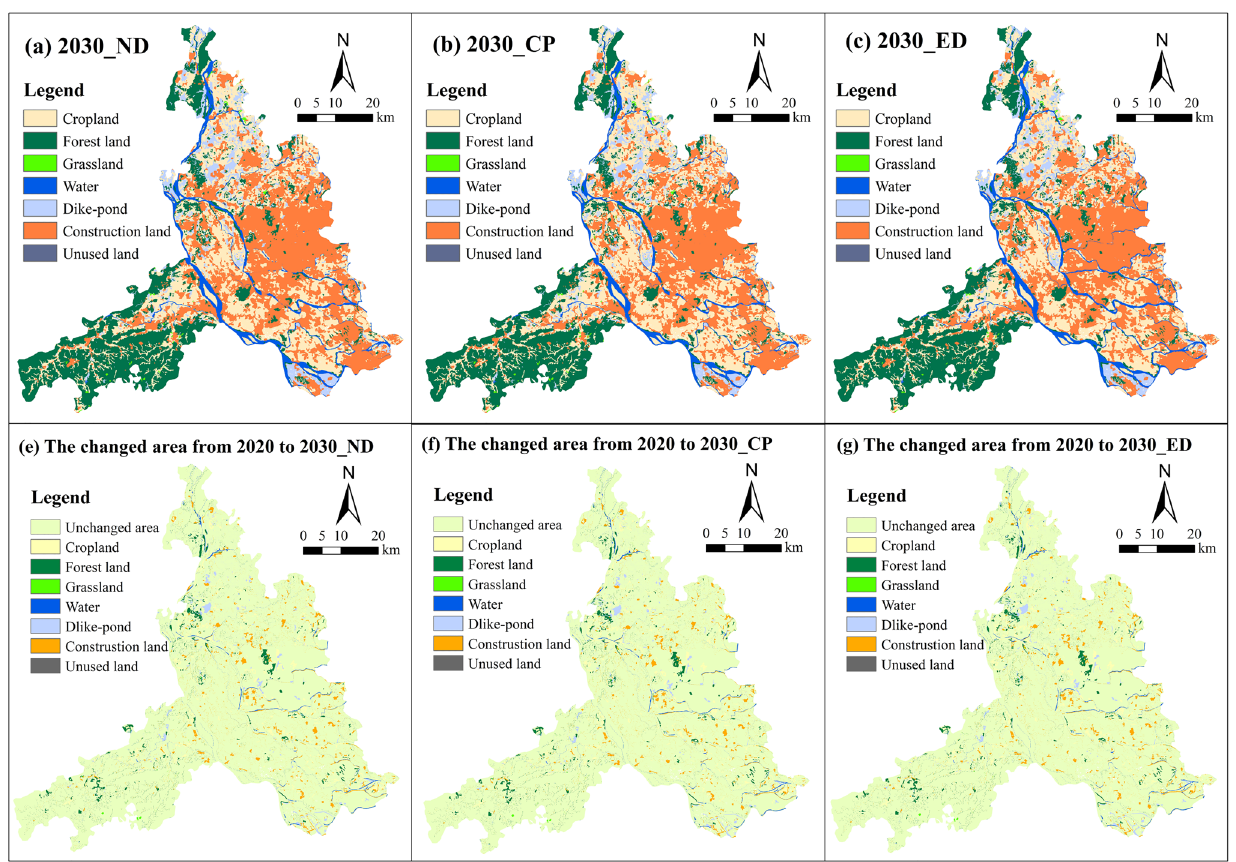
Scenario (ED); d Change area under ND scenario in 2020-2030; e Change area under CP scenario in 2020-2030; f Change area under ED scenario in 2020-2030.